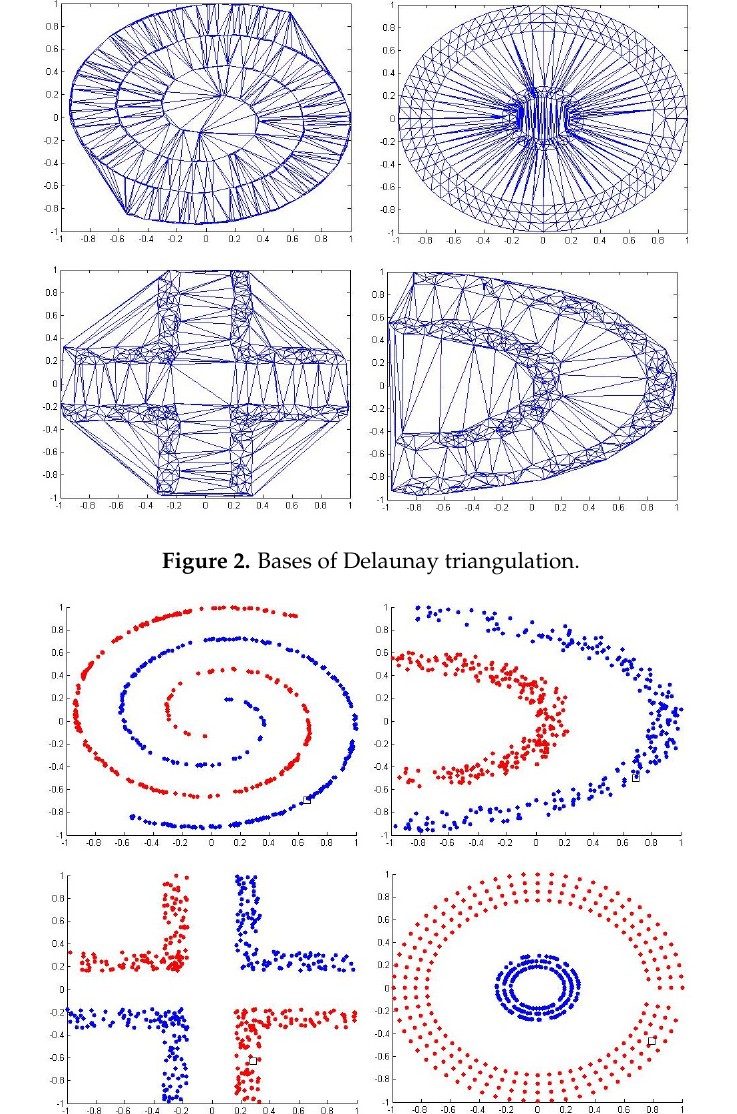
Figure 3. Positive and negative samples in each data